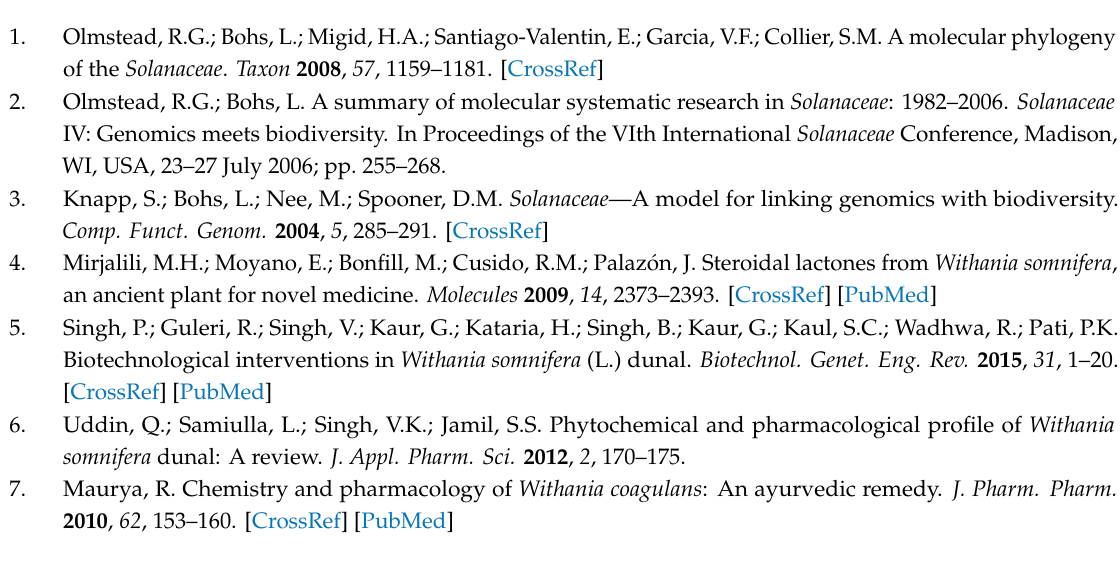
Table S1: Base composition in the chloroplast genome of W. somnifera , W. coagulans , W. adpressa and W. riebeckii ; Table S2: Codon usage in the chloroplast genome of W. somnifera , W. coagulans , W. adpressa and W. riebeckii ; Table S3: Putative RNA editing sites composition in the chloroplast genome of W. somnifera , W. coagulans , W. adpressa and W. riebeckii ; Table S4: Comparison of synonymous and non-synonymous substitution in Withania species S5: Microsatellites loci in the chloroplast genome of W. somnifera , W. coagulans , W. adpressa and W. riebeckii ; Table S6: Oligonucleotide repeats in chloroplast genomes of W. somnifera , W. coagulans , W. adpressa and W. riebeckii ; Table S7: Tandem Repeat sequences in the chloroplast genome of W. somnifera , W. coagulans , W. adpressa and W. riebeckii ; Table S8: The distribution and characteristics of SNPs found among Withania plastid genomes; Table S9: NCBI GenBank accession numbers used in this study; Table S10: Model selected for each data partition identified by software Partition Finder for protein-coding chloroplast genes and intron regions in maximum likelihood (ML) analysis and Bayesian inference